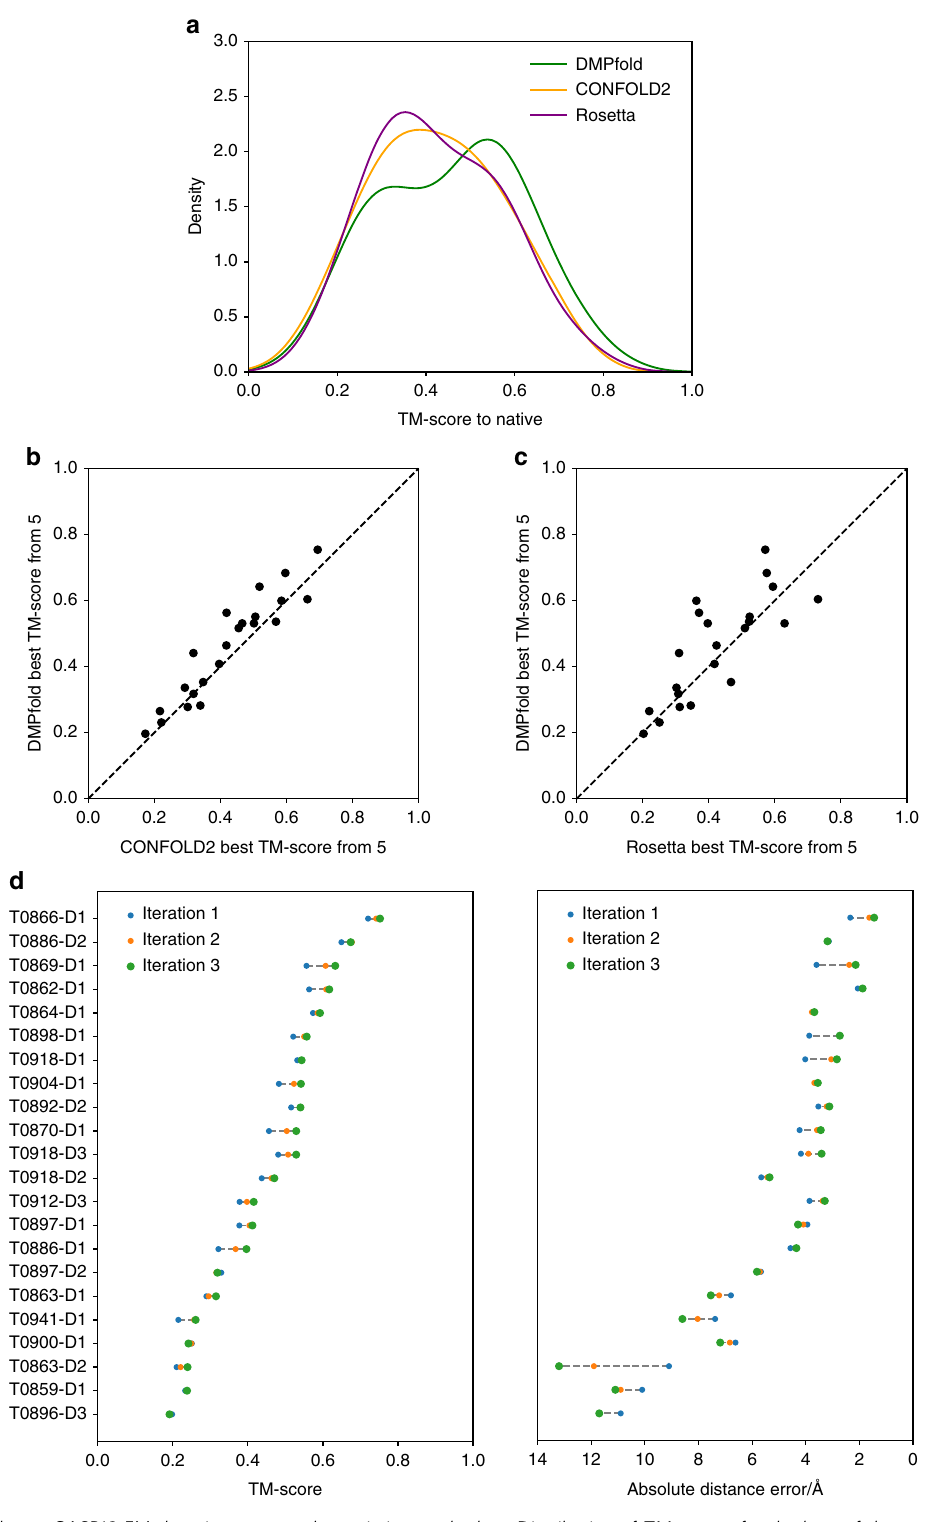
Fig. 2 DMPfold results on CASP12 FM domains compared to existing methods. a Distribution of TM-scores for the best of the top 5 models for each CASP12 FM domain. b Comparison of DMPfold and CONFOLD2 best of top 5 models. The dashed line indicates the point of equal quality models between the two methods, which both use CNS. c Similar to b but for Rosetta. d The change in TM-score and absolute distance error with DMPfold iterations for each domain. Domains are ordered by decreasing iteration 3